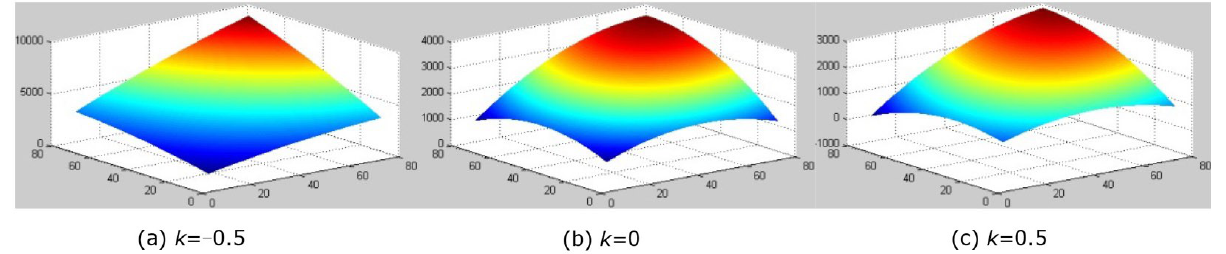
Figure 3. Relationship between project values added and the incentive amplitude of knowledge investment and knowledge innovation under different k